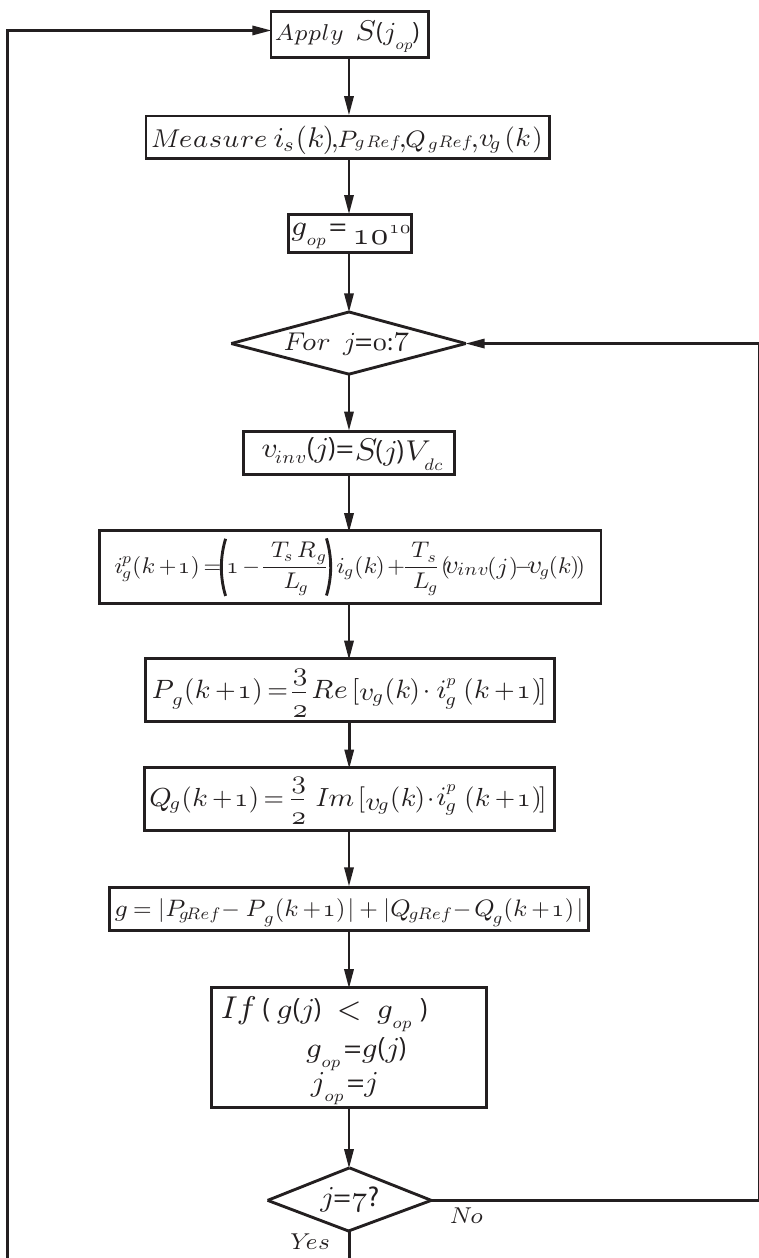
Figure 16. Flowchart for direct predictive power